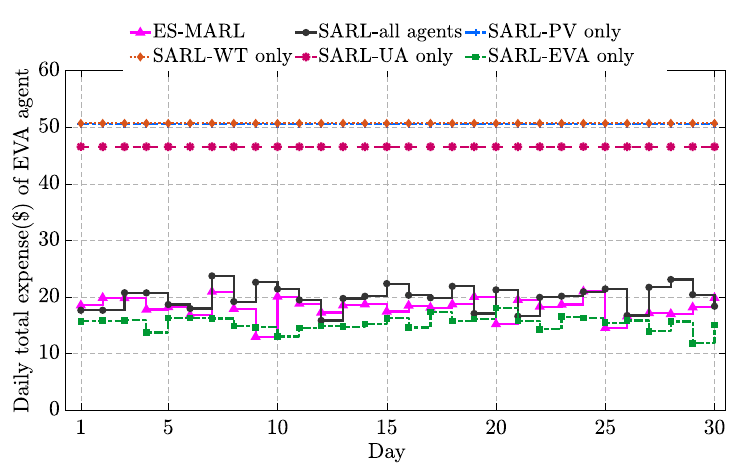
Figure 7. UA agent’s daily welfare in different RL configurations.